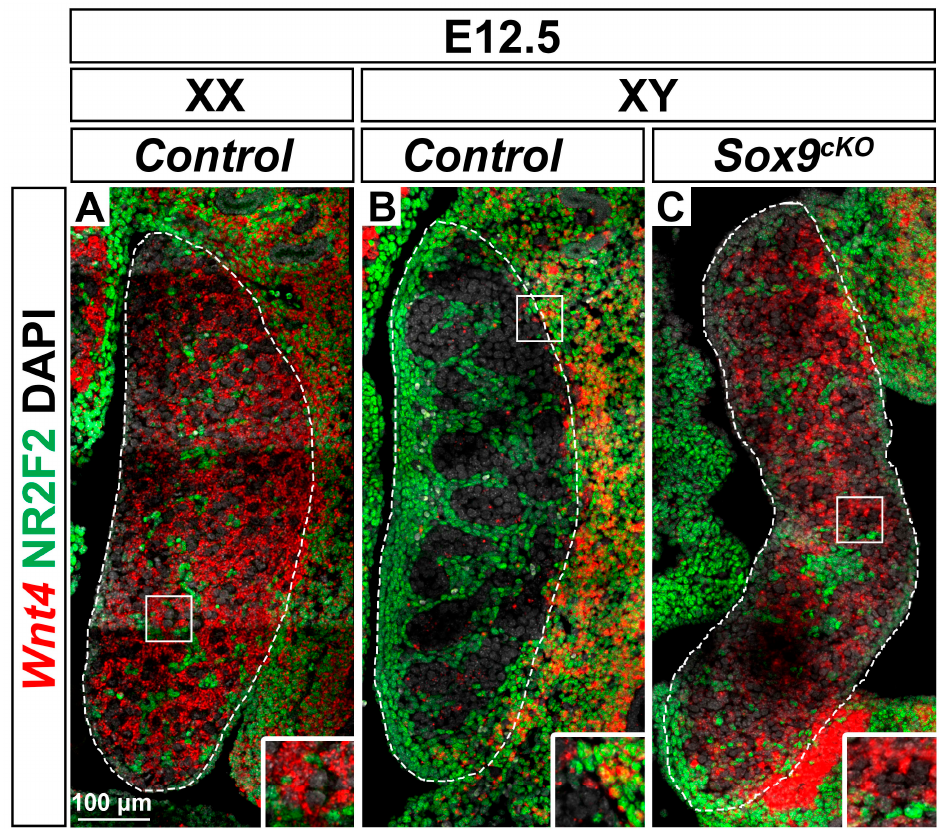
Figure 3. Wnt4 expression is up-regulated in XY Sox9 mutant gonads. ( A , B ) RNAscope ® detection of Wnt4 transcripts (red) together with immunodetection of the interstitial and stromal cell marker NR2F2 (green) in E12.5 XX Control gonad ( A ), XY Control gonad ( B ), and XY Sox9 cKO gonad ( C ). Nuclei labeled with DAPI are shown in grey. Magnification is the same in all panels. Scale bar = 100 µ m. Gonads are outlined with broken white lines.